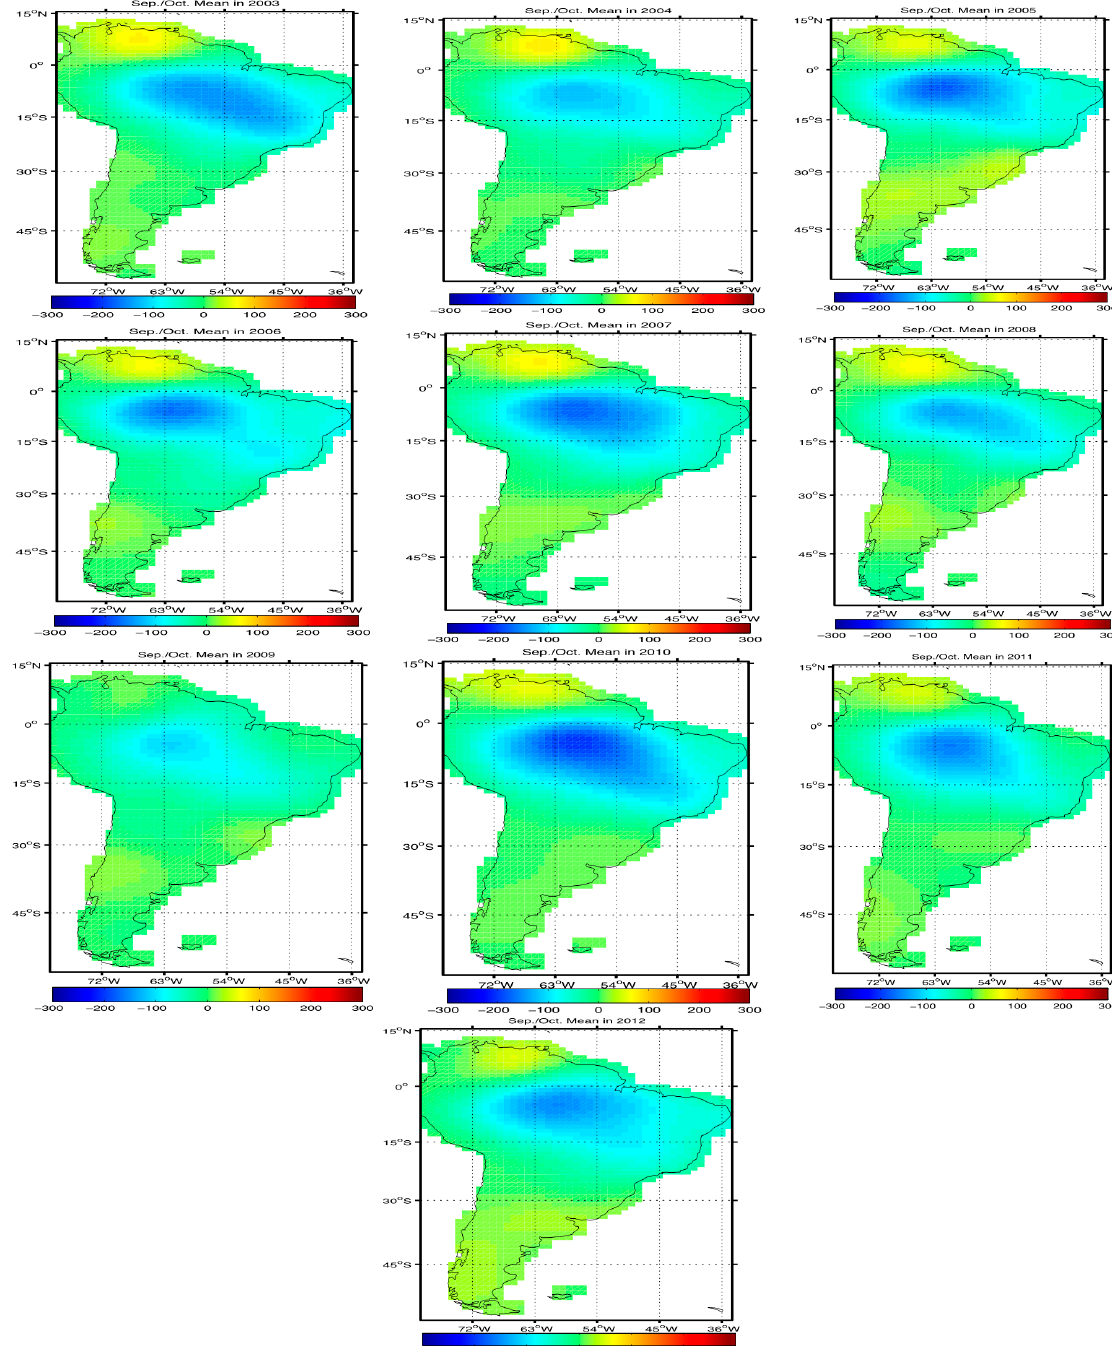
Figure 11. GRACE-averaged September and October water storage changes (unit: mm) in the Amazon after a Gaussian filter with half wavelength is applied at 500 km. From left to right and from top to bottom are years from 2003 to 2012 successively.